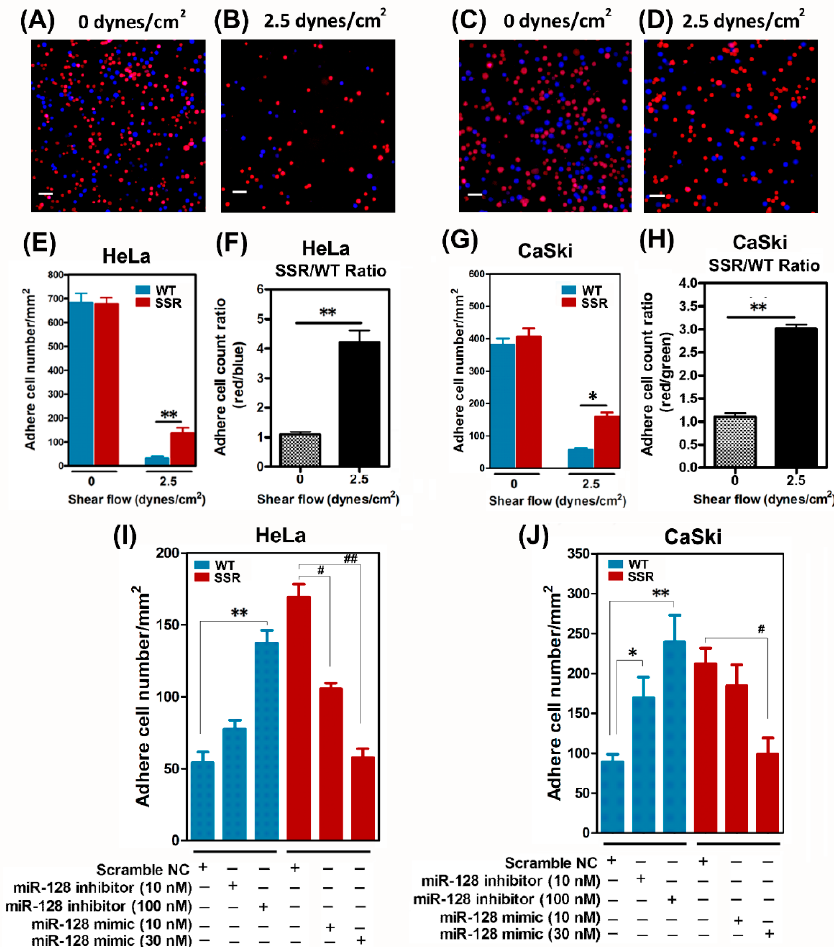
Figure 3. Increased static adhesion capacities in SSR-HeLa and SSR-CaSki cervical cancer cells measured by a parallel-plate flow chamber system. Overexpression of miR-128 reduced the SSR-enhanced cervical cancer cells’ adhesion to endothelial cells. The adhesion capacity of the SSR and WT clones was measured by a static adhesion assay, as described in Section 4.7. In brief, mixtures containing 1 × 10 5 Orange Red CMRA prelabeled SSR cells and 1 × 10 5 Blue CMF2HC prelabeled WT cells were gently infused into the flow chamber and kept there for 12 min to let the cervical cancer cells settle onto the human umbilical cord vein endothelial cell (HUVEC) layer. This was followed by perfusion with 0 or 2.5 dyn/cm 2 shear flow for 10 min. HeLa cells adhered to HUVECs after ( A ) 0 dyn/cm 2 or ( B ) 2.5 dyn/cm 2 shear flow for 10 min. Similar, CaSki cells was shown to adhere on HUVECs after ( C ) 0 dyn/cm 2 or ( D ) 2.5 dyn/cm 2 shear flow for 10 min. Scale bar, 100 µ m. ( E , F ) In HeLa cells, the SSR cells adhered on the HUVECs layer (red fluorescence) and WT cells (blue fluorescence; without exposure to shear stress) and the cell ratio of SSR/WT was nearly 1:1. Increased SSR cells’ adherence onto the ECs compared to WT cells was seen after exposure to 2.5 dynes/cm 2 shear stress for 10 min. ( F ) Data are expressed as the number of cells positive for red fluorescence (SSR)/the number of cell positive for blue fluorescence (WT). A similar phenomenon was observed in CaSki cell clones ( G , H ). ( I ) HeLa or ( J ) CaSki cells were transfected with synthetic miR-128 inhibitor oligonucleotides, miR-128 mimic oligonucleotides, or scramble negative control oligonucleotides for 48 h and then we performed the static adhesion assay. All the experiments were repeated three times and at least six fields were counted per experiment. Each dataset was reported as the mean ± SD; * P < 0.05, ** P < 0.01 for the WT + miR-128 inhibitor group vs. WT group; # P < 0.05, ## P < 0.01 for the SSR + miR-128 mimic group vs. SSR